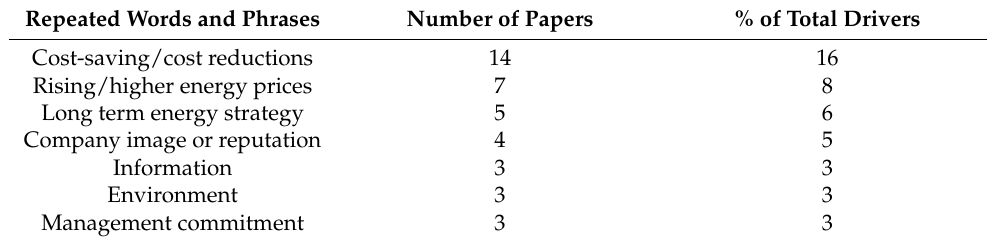
Table 3. Prevalence of keywords and/or phrases identified in drivers extracted from articles using survey and/or interview as a data source.